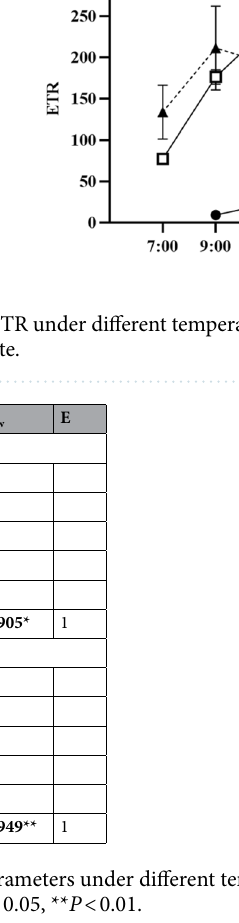
(Table S1). Taking |log2FC|> 2 and the average FPKMs of samples among groups > 1 as the standard, the signifi- cantly enriched differential genes were screened out. There were 18,904 differentially expressed genes (DEGs) in the CK vs. LT groups and 15,326 DEGs in the CK vs. HT groups. The Gene Ontology (GO) project is divided into three functional categories: biological processes, cellular components and molecular functions. The results of GO classification in the CK vs. LT groups and the CK vs. HT groups were similar. In the biological processes, the numbers of DEGs in cellular processes and metabolic processes were large; in the cell component, the number